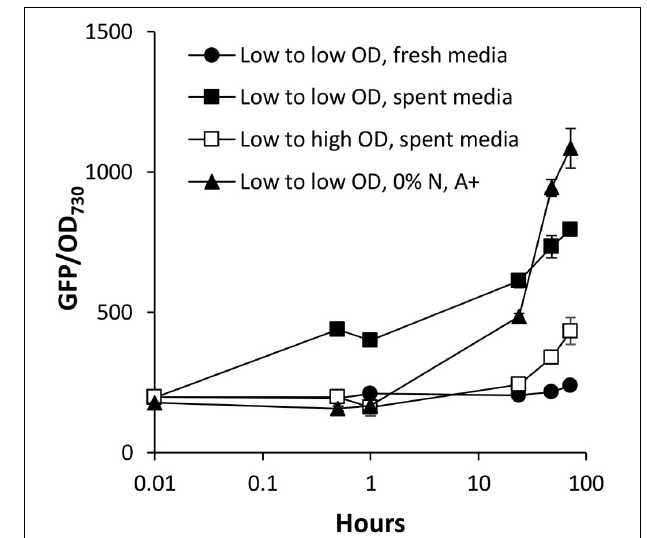
FIGURE 8 | Early kinetics of PndbA600 activation. Early responses of PndbA600 in Synechococcus PndbA600:GFP to different treatments at time point 0: low OD < 5 to low OD 1 in fresh control medium (black circles), low OD < 5 to low OD 1 in spent medium (black squares), low OD < 5 to high OD 12 in spent medium (white squares), or low OD < 5 to low OD 1 in N-deficient medium (0% N in A + background, black triangles). Data are means ± S.E.M. of three independent